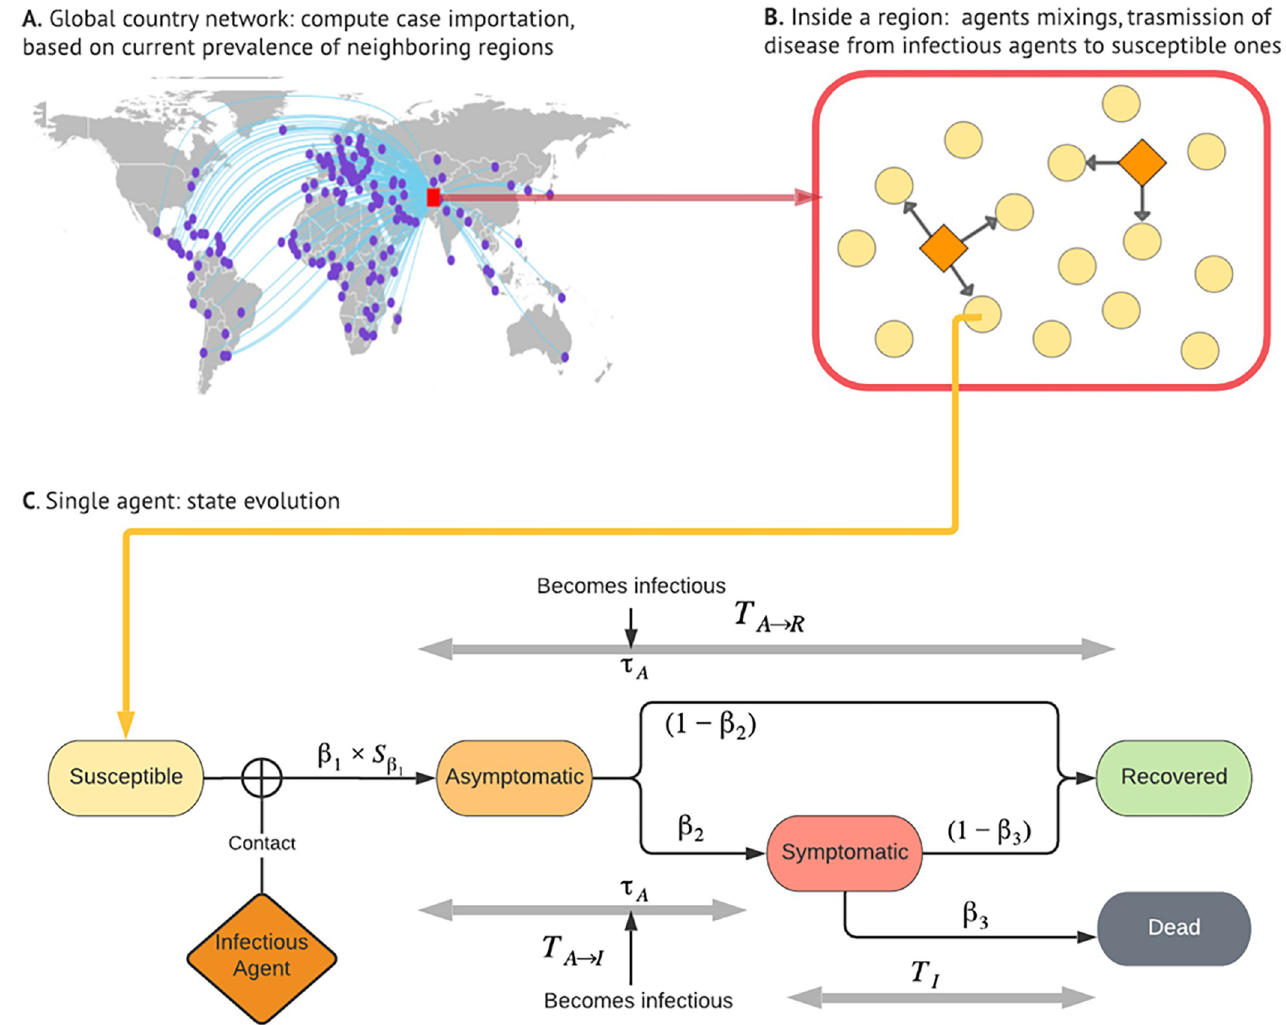
Fig 1. Simulation Framework. Note: the global map was made using the R package “maps”. The original source of the base layer is Natural Earth, whose Terms of Use explicitly state that "No permission is needed to use Natural Earth. Crediting the authors is unnecessary." https://www.naturalearthdata.com/